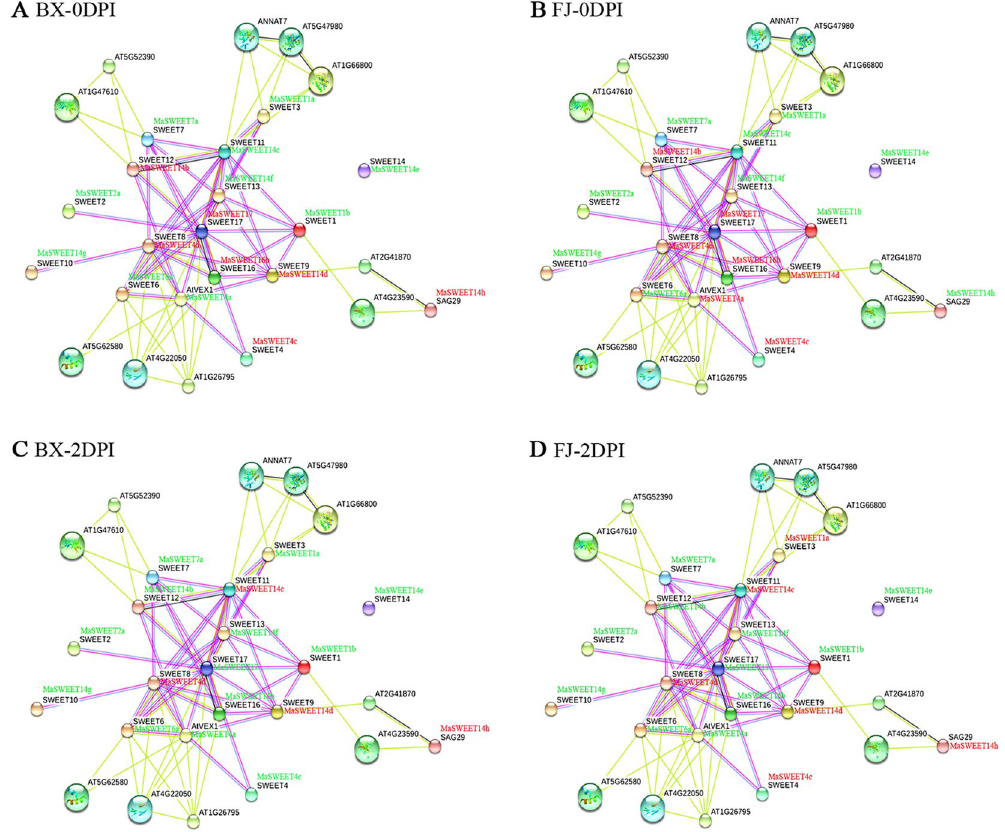
Figure 11. Interaction network and co-expression analyses of MaSWEETs at 0 DPI ( A , B ) and 2 DPI ( C , D ) in BX and FJ banana varieties and related genes in Arabidopsis . Line thickness relates to combined score. Genes marked in red show upregulation in BX and FJ. Genes marked in green show downregulation in BX and